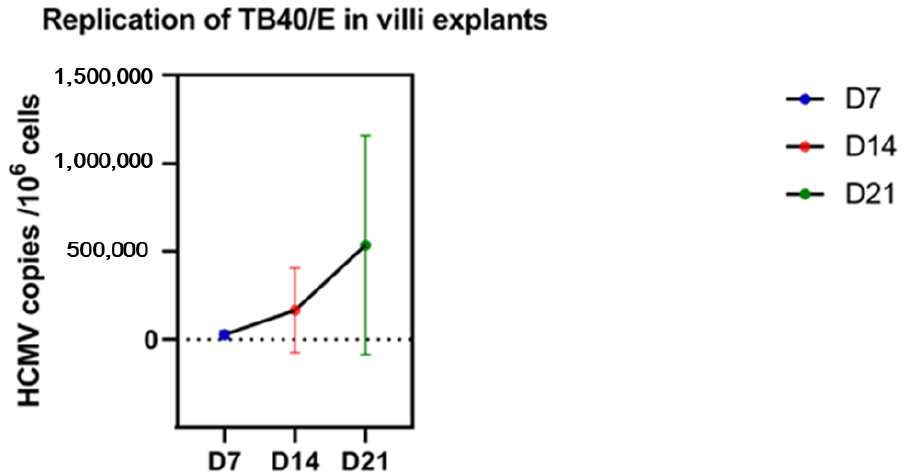
Figure 3. Kinetics of the endotheliotropic strain TB40/E in villi explants. The mean viral loads on days 7, 14, and 21 post-infection in the villi explants. The whiskers are extended to the extreme data